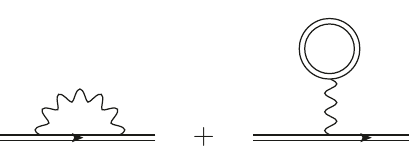
Figure 2 . One-loop corrections to the charged particle propagator in an external electromagnetic